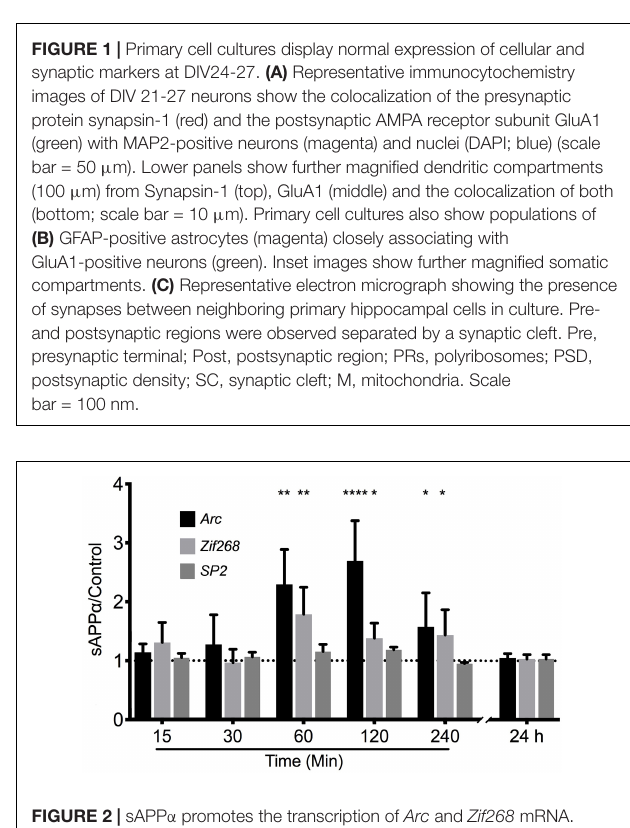
FIGURE 2 | sAPP α promotes the transcription of Arc and Zif268 mRNA. RT-qPCR showed that sAPP α (1 nM) promotes an increase in the expression of Arc mRNA in primary cortical cells in culture at 60, 120 min ( n = 5) and 240 min ( n = 4) relative to no-drug controls ( n = 9; mean ± SEM). No significant change was detected at 15 or 30 min, nor 24 h ( n = 4), nor was there a significant change in the negative control gene SP2 ( n = 4). One sample t -tests; ∗ p ≤ 0.05, ∗∗ p ≤ 0.01, ∗∗∗∗ p ≤ 0.0001.